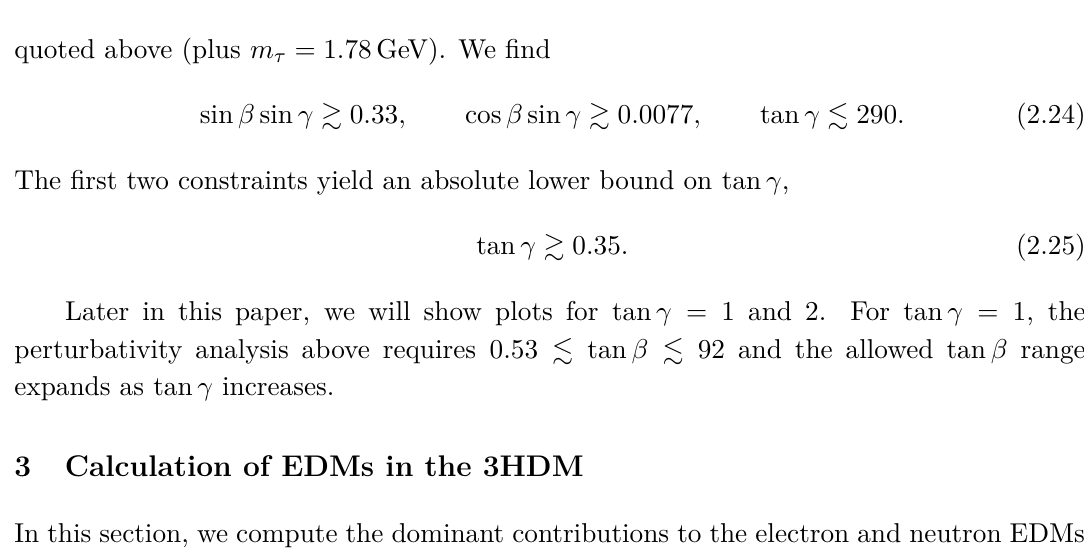
Figure 6 . One of the Barr-Zee type diagrams that give the dominant charged Higgs boson contri- bution to the eEDM in the